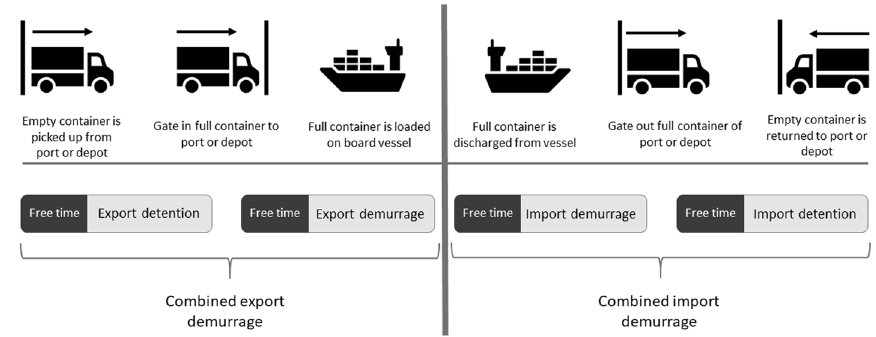
Fig. 2 Structure of demurrage and detention. Source : own composition based on Storm (2011) and Maersk (2017,